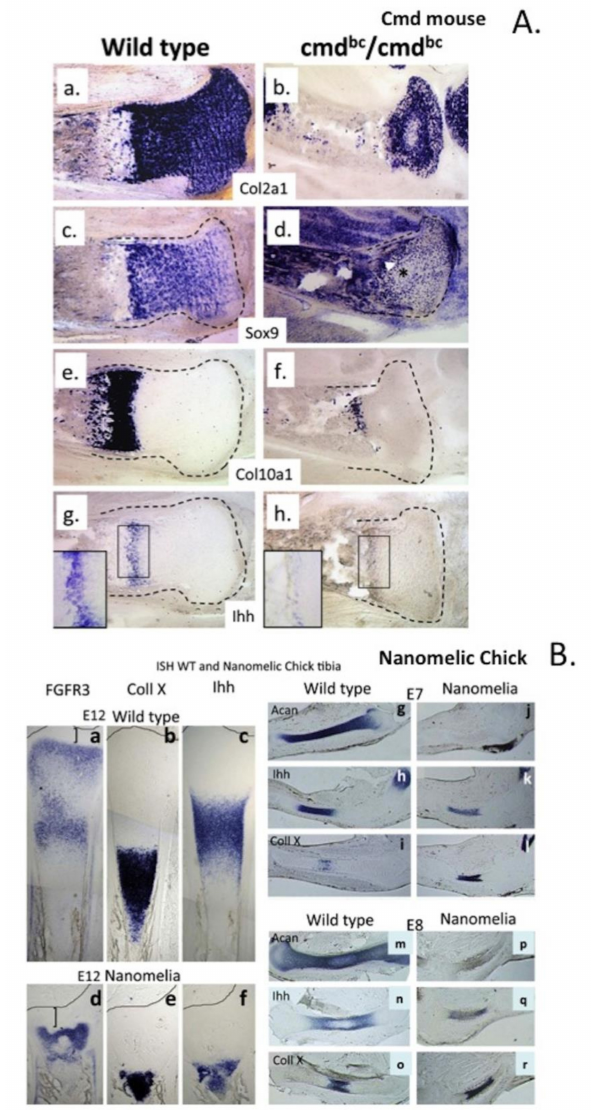
Figure 4. Demonstration of the modulation of growth plate cartilage morphogenesis by aggrecan in wild type (WT) ( A ) ( a – h ) and nanomelic E7-E12 chick tibia ( B ) ( a – r ). The ISH images presented demonstrate the expression of: FGFR3 ( a ); type X collagen ( b ); and Indian Hedgehog (IHH) ( c ) in WT ( a – c ); and nanomelic growth plate ( d – f ) in E12 ( a – f ); E7 ( g – l ); and E8 chick tibia ( m – r ). Images modified from [134] with permission using open